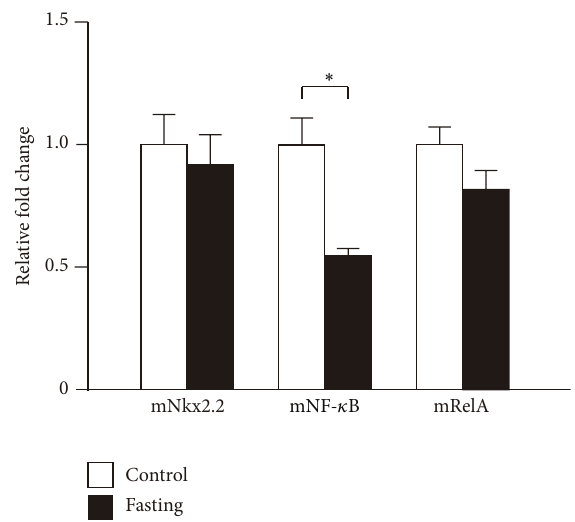
Figure 10: Expression of transcription factors in fasting mice. The cDNA of 36-hour fasting and control mice was synthesized from their stomach mRNAs and used as the templates for PCR analyses. PCR products of mouse Nkx2.2, NF- 𝜅 B (NF- 𝜅 B (p50)), and RelA (NF- 𝜅 B (p65)) were separated by agarose gel electrophoresis and stained with ethidium bromide. Asterisks indicate the differences between each group ( 𝑃 < 0.05